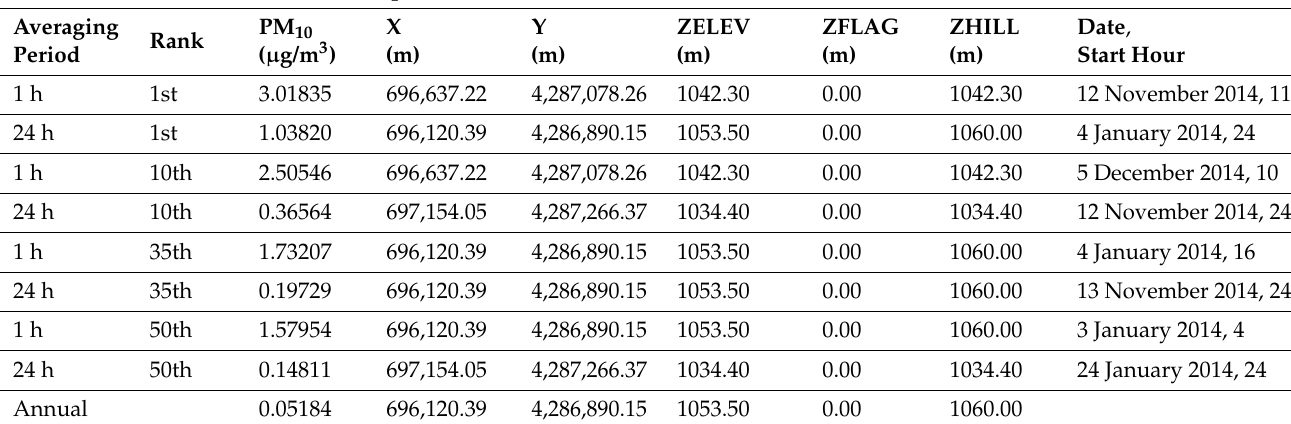
Table S1: The points used in AERMOD scenarios and their sectors; Table S2: Limit values for heavy metal pollution; Table S3: The PM10 emission rates (kg/h) for each point source; Table S4: Meteorology pathway of the AERMOD